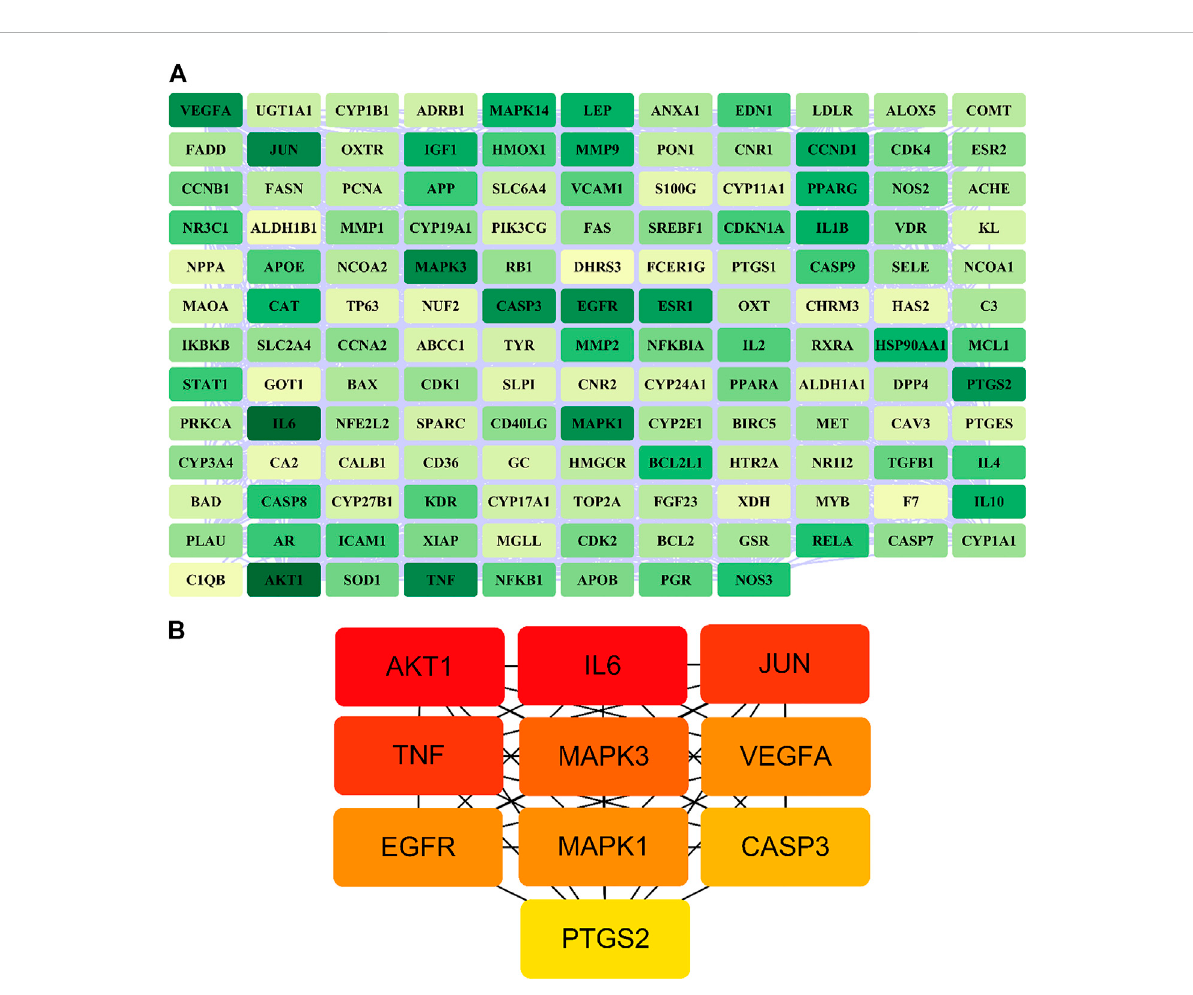
FIGURE 4 PPI network of potential target genes and top 10 hub genes for Gusuibu against osteoporosis. (A) PPI network constructed by using Cytoscape software. (B) The top 10 hub genes was identi fi ed by the Degree